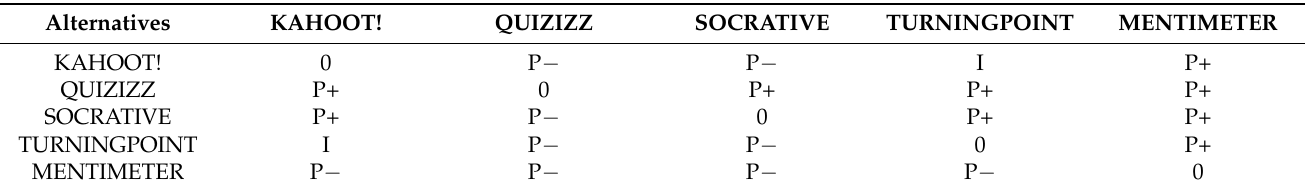
Table 14. Dominance Matrix in ELECTRE III. P+ means an alternative A i that is better than alternative A j . I means that an altenative A i is equivalent to alternative A j . P- means that A i is as good as alternative A j .